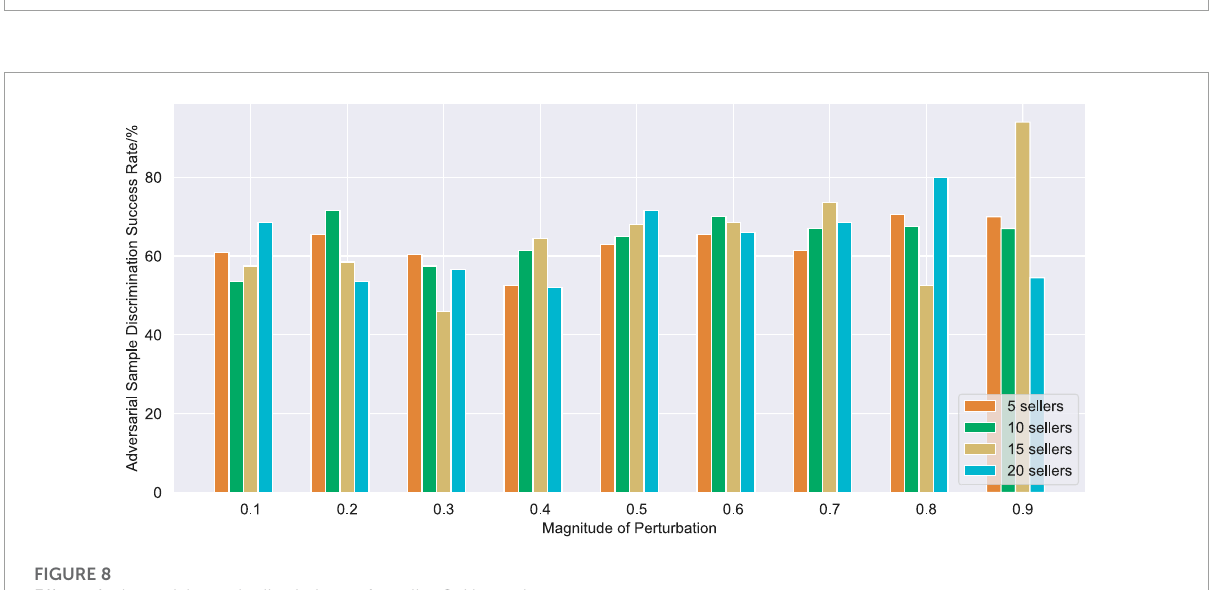
FIGURE 8 Effect of adversarial sample discriminator for seller